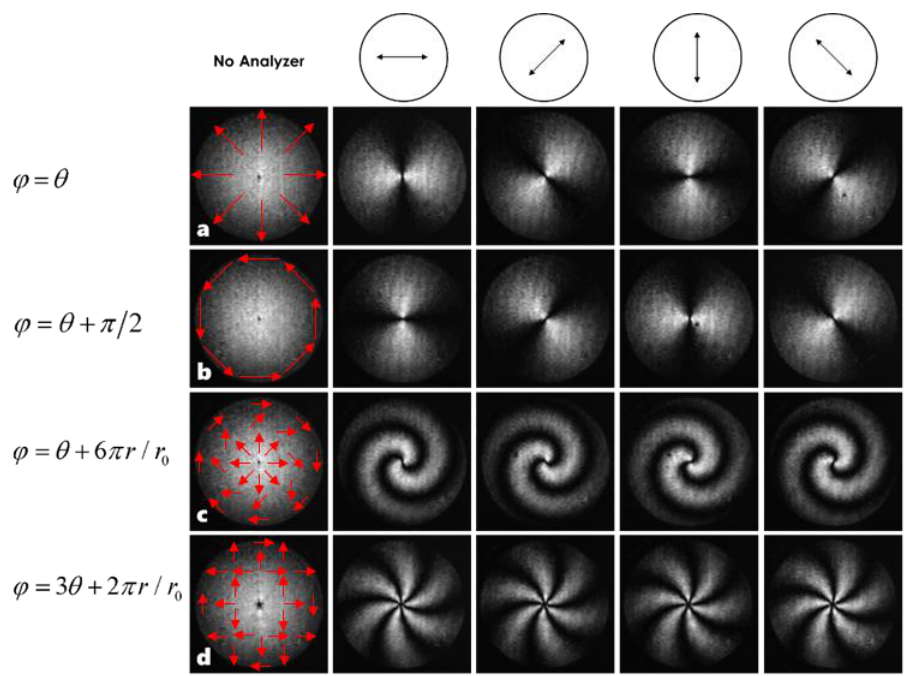
Figure 3. ( a – d ) shows the intensity distribution of the optical field under different direction polarizers when ϕ is taken as ϕ = θ , ϕ = θ + π /2, ϕ = θ + 6 π r / r 0 , and ϕ = 3 θ + 2 π r / r 0 , respectively. The polarization analyzer’s orientation that positions the image sensor’s front is shown by the arrow at the top of the image.